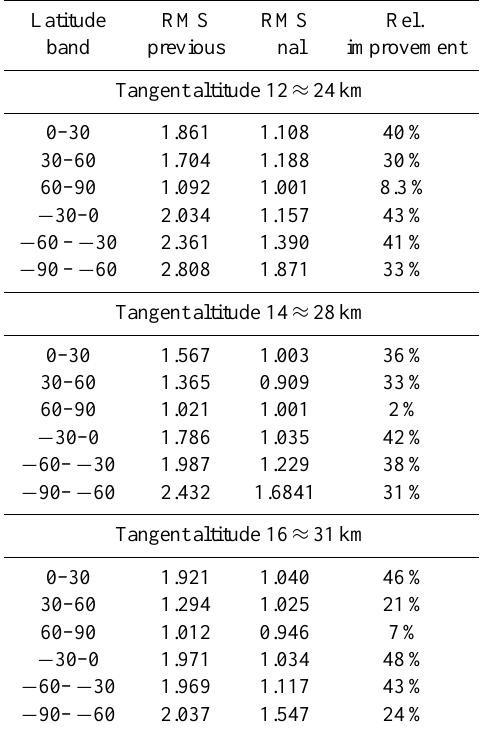
Table 1. Previous and final RMS of the residual for tangent altitude 12, 14 and 16 with coadded spectra over 1